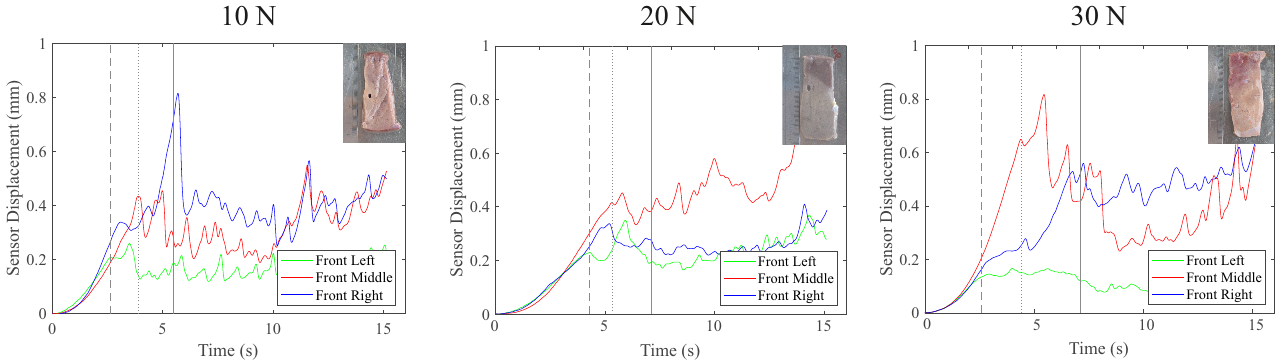
Figure 8. Graphs showing example sensor displacement for cases in which the early detection of slip was successful for porcine liver samples for various load cases. The vertical dashed and dotted lines indicate the time slip was first detected at the outer and middle islands, respectively, whereas the solid vertical line indicates the time of macro